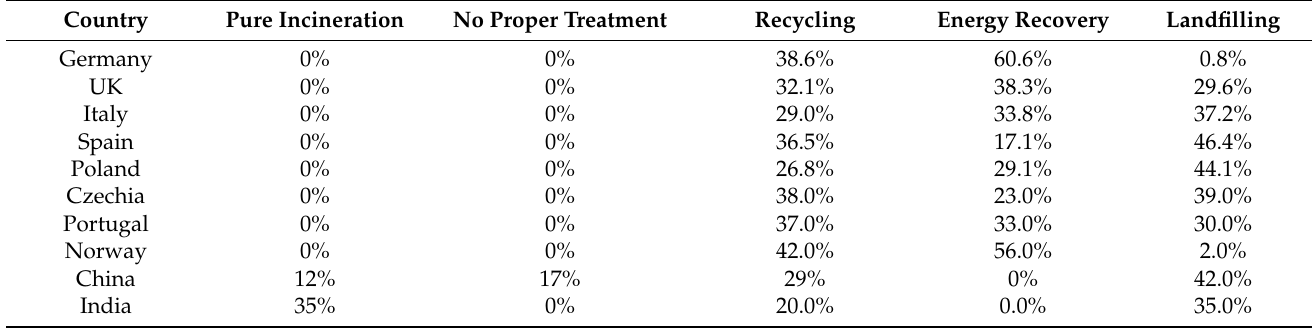
Table 30. Plastic waste split depending on the country and the management strategy or process chosen [83–85].